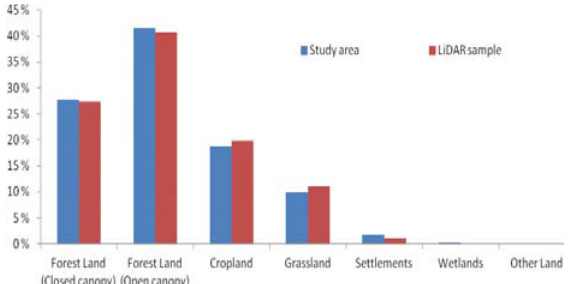
Figure 7. Land Use (LU) Class Proportions, Study Area vs.